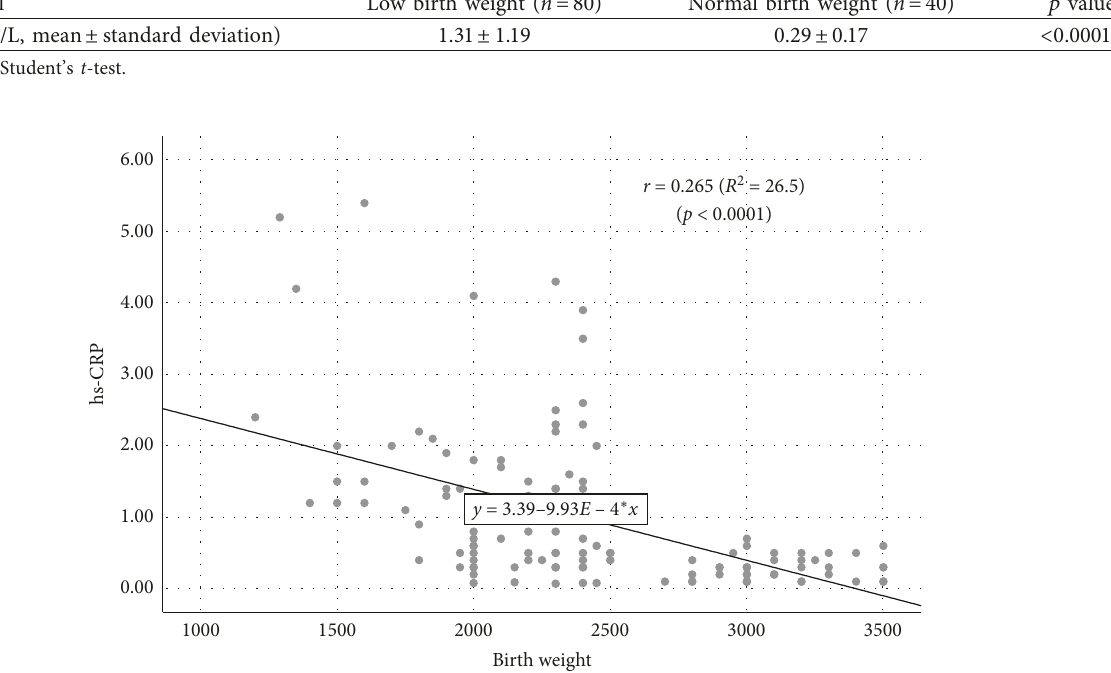
Figure 4: Scatterplot diagram for the association between birth weight and serum hs-CRP level.